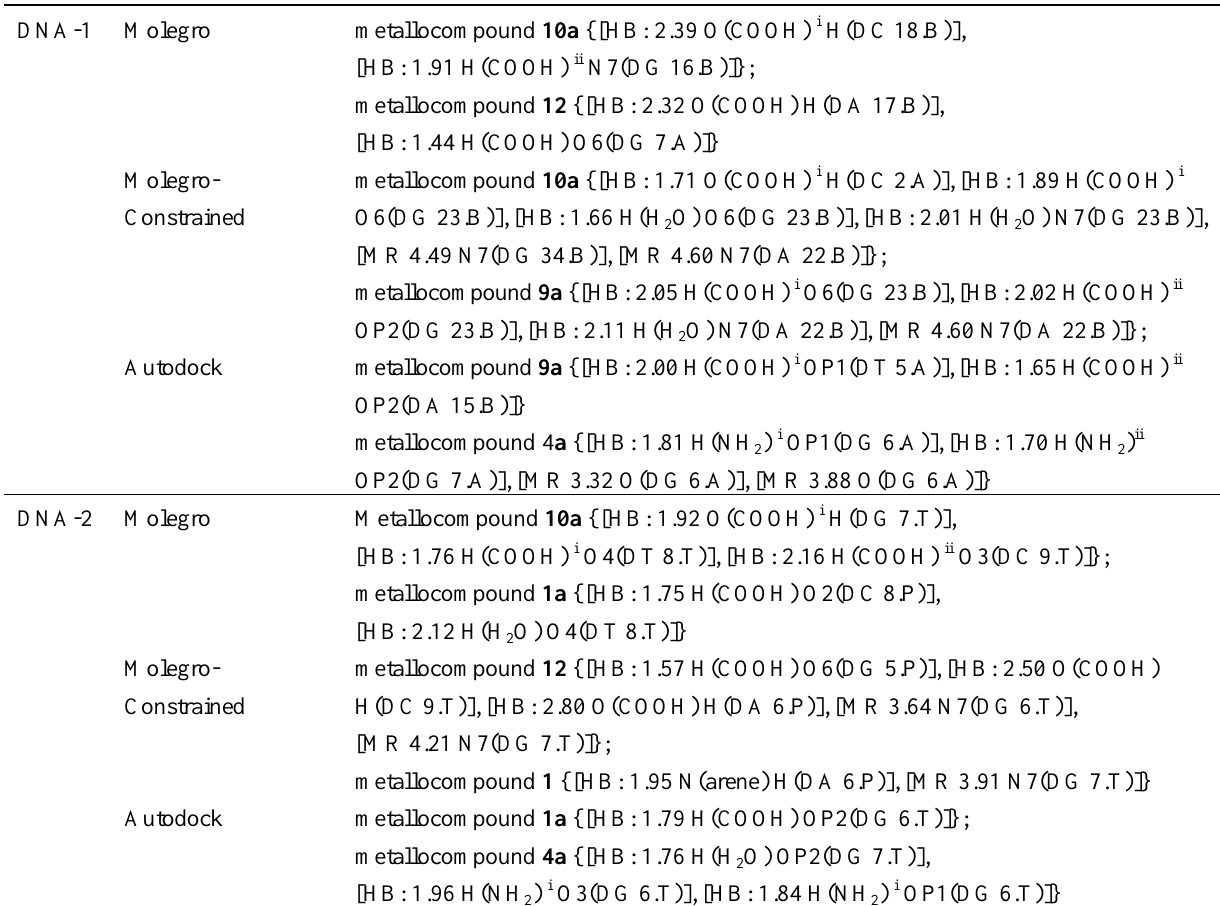
Table 1. The two best binding metallocomponds of each receptor from Molegro and Autodock showing the existing Hydrogen Bond (HB) (in Å) and Metal-Residues (MR) interactions with binding site